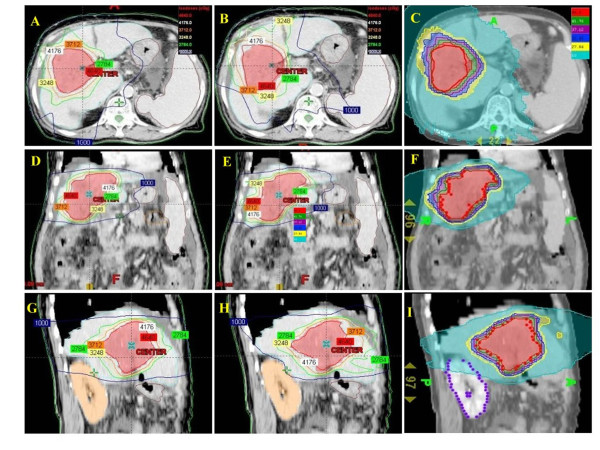
Isodose distributions of prescribed dose of 46.4 Gy to PTV for different treatment techniques. A, D and G showed the isodose axial, coronal and sagittal views for coplanar IMRT plan respectively. B, E and H were the isodose axial, coronal and sagittal views for noncoplanar IMRT plan. The helical tomotherapy plan was shown in C, F and I.